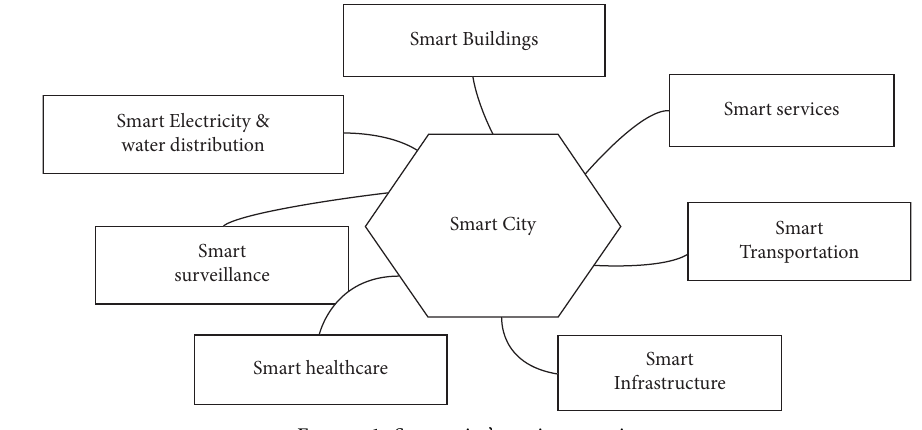
Figure 1: Smart city’s various